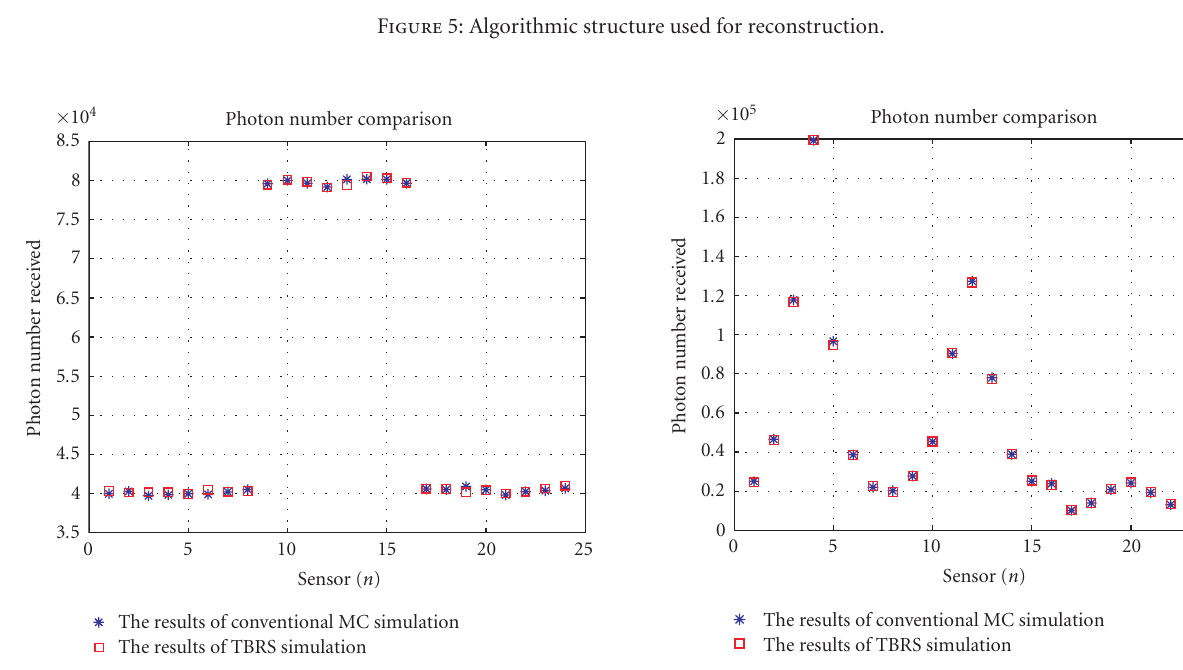
Figure 6: Photons received by the 24 sensors with source in (0,0,0). Figure 7: Photons received by the 24 detectors with source in